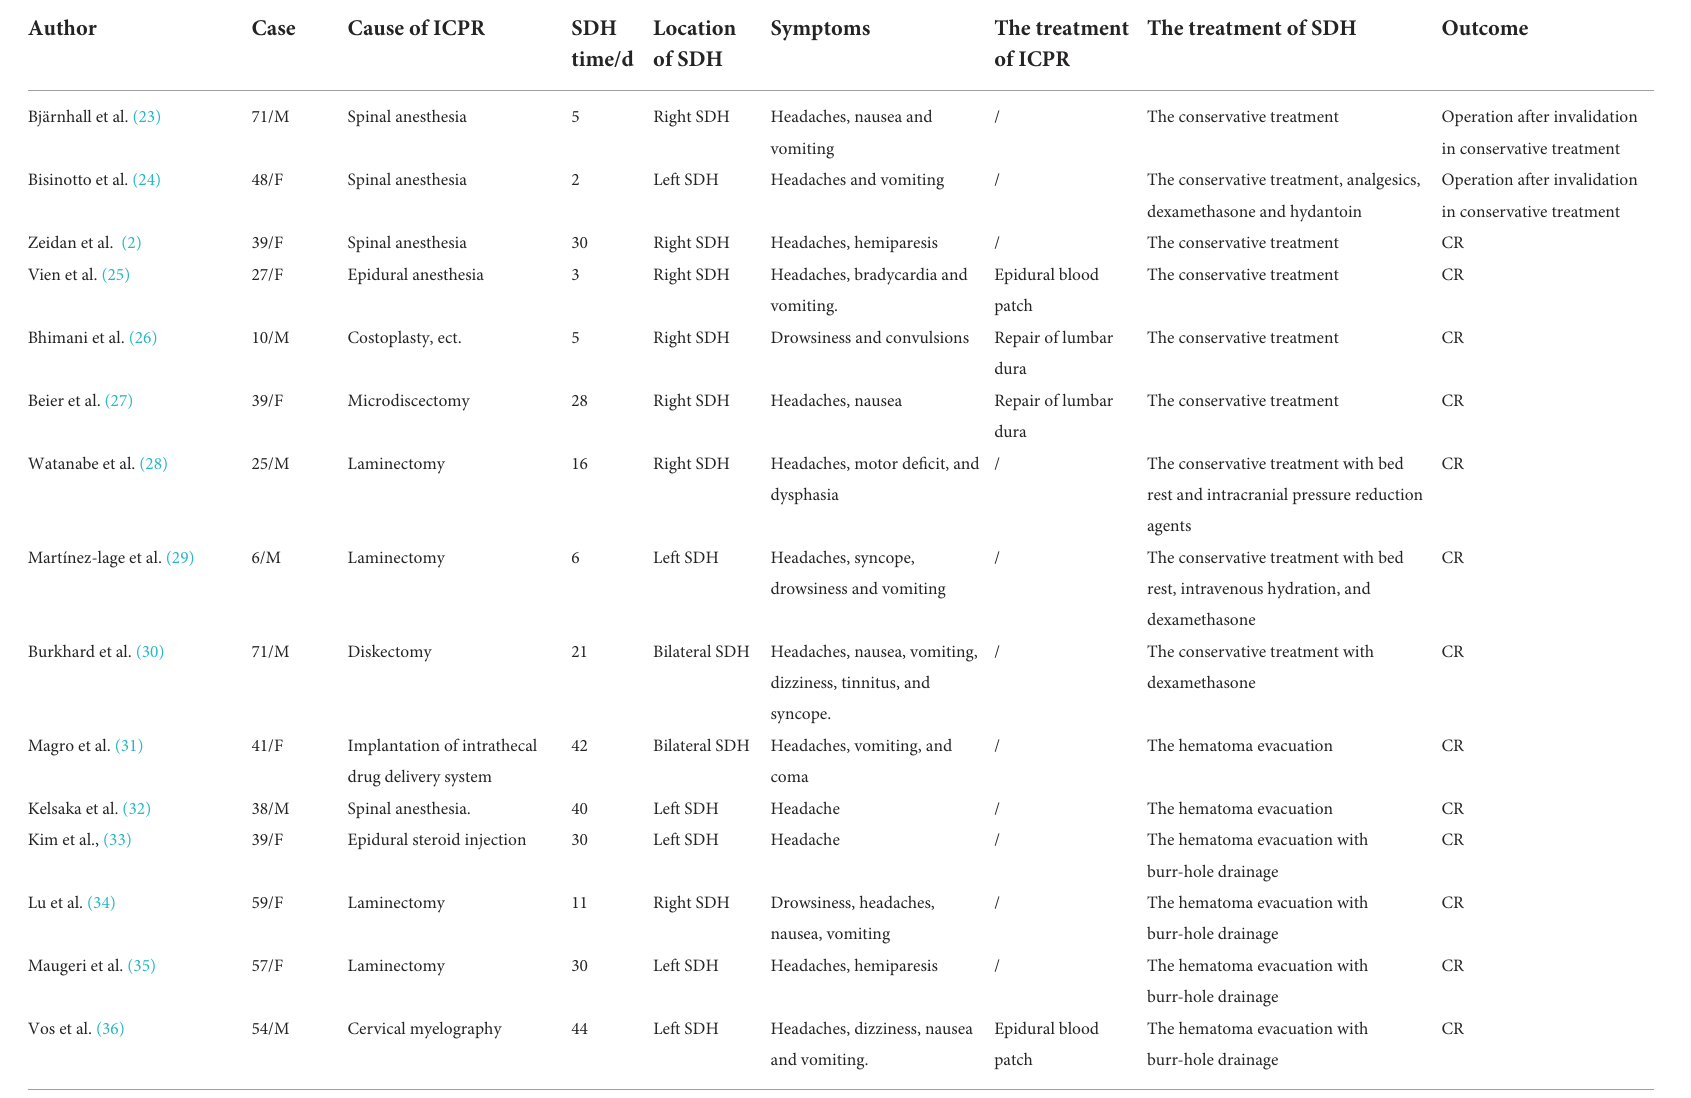
TABLE 1 Cases of secondary ICPR-related